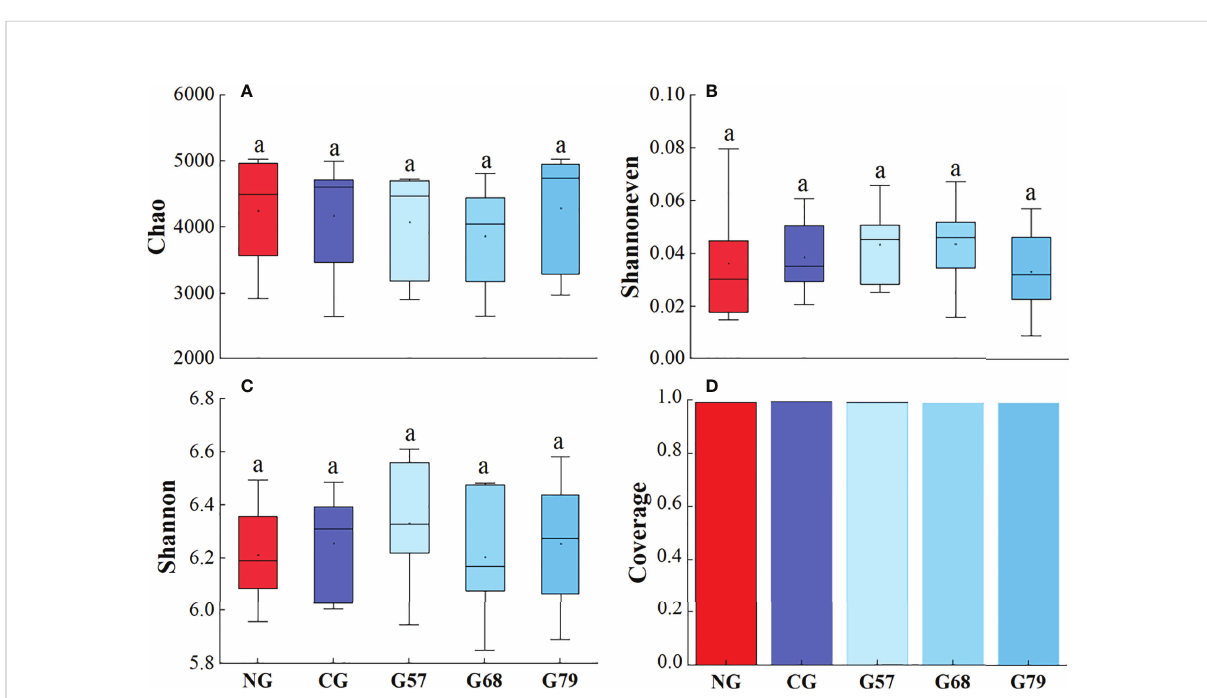
FIGURE 5 Soil bacterial diversity in fi ve grassland management treatments: (A) Chao; (B) Shannoneven; (C) Shannon; (D) Coverage. NG: No grazing; CG: Continuous grazing; G57: Grazing in May and July; G68: Grazing in June and August; G79: Grazing in July and September. The error bars in the fi gure represent the standard error, and the lowercase letters represent the signi fi cant differences ( P